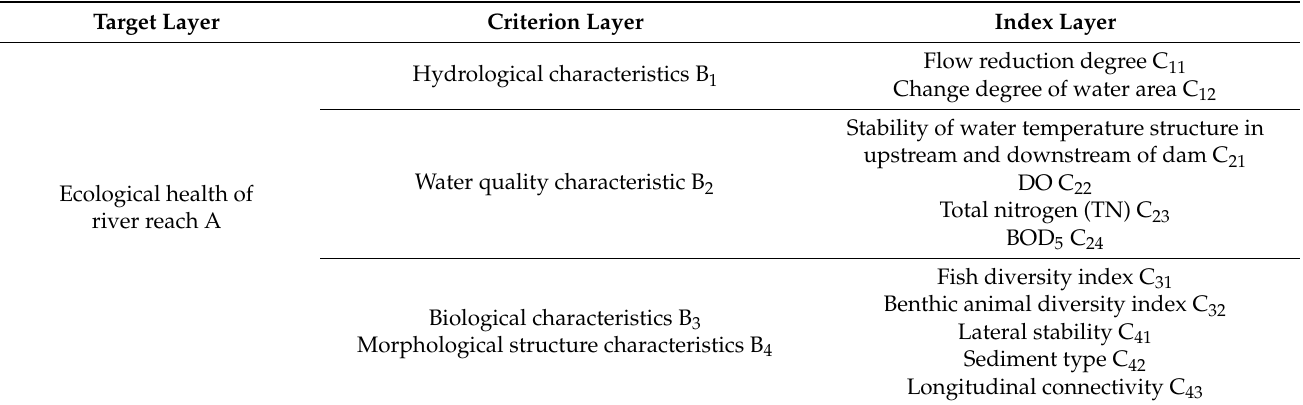
Table 1. Hierarchy of the ecological health assessment system of the river reach after the retirement and renovation of small hydropower